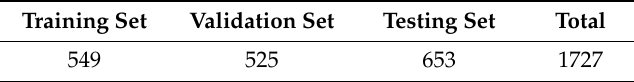
Table 3. Composition of the marine target detection